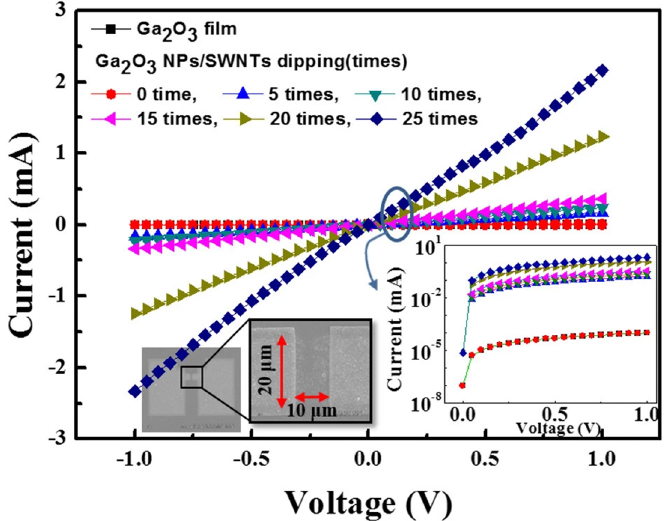
Materials 2021 , 14 , x FOR PEER REVIEW Figure 6. Current–voltage characteristic curves [41]. Figure 6. Current–voltage characteristic curves [41]. Figure 6. Current–voltage characteristic curves [41].